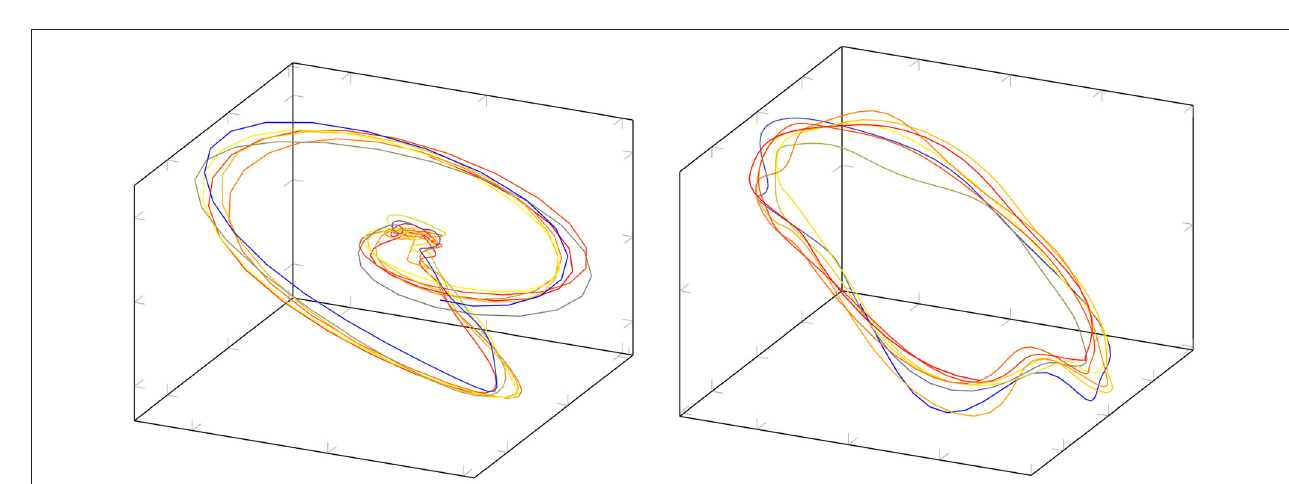
FIGURE 7 | Examples of the projected signal in phase space. The example on the left hand side seems to represent a homoclinic orbit, the trajectory on the right hand resembles a circle. The color indicates the time evolution of the trajectory.